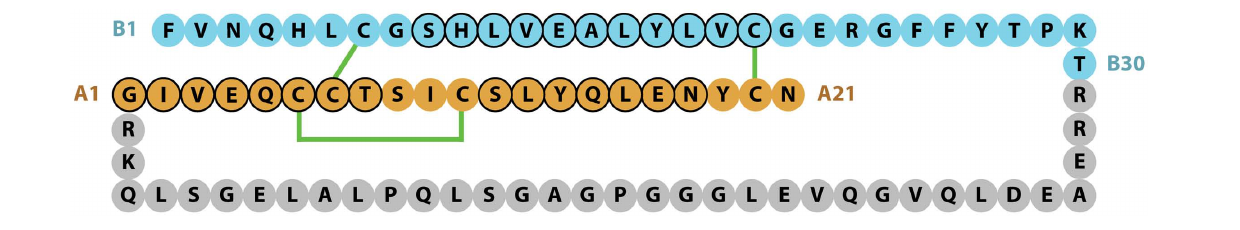
FIGURE 1 | Sequence of human insulin precursor. The B- and A-chain segments of the processed protein are shown in cyan and light brown color, respectively, with the proteolytically removed C-peptide in gray. Disulfide bonds are indicated in green, while residues adopting a helical conformation in the mature protein are circled in